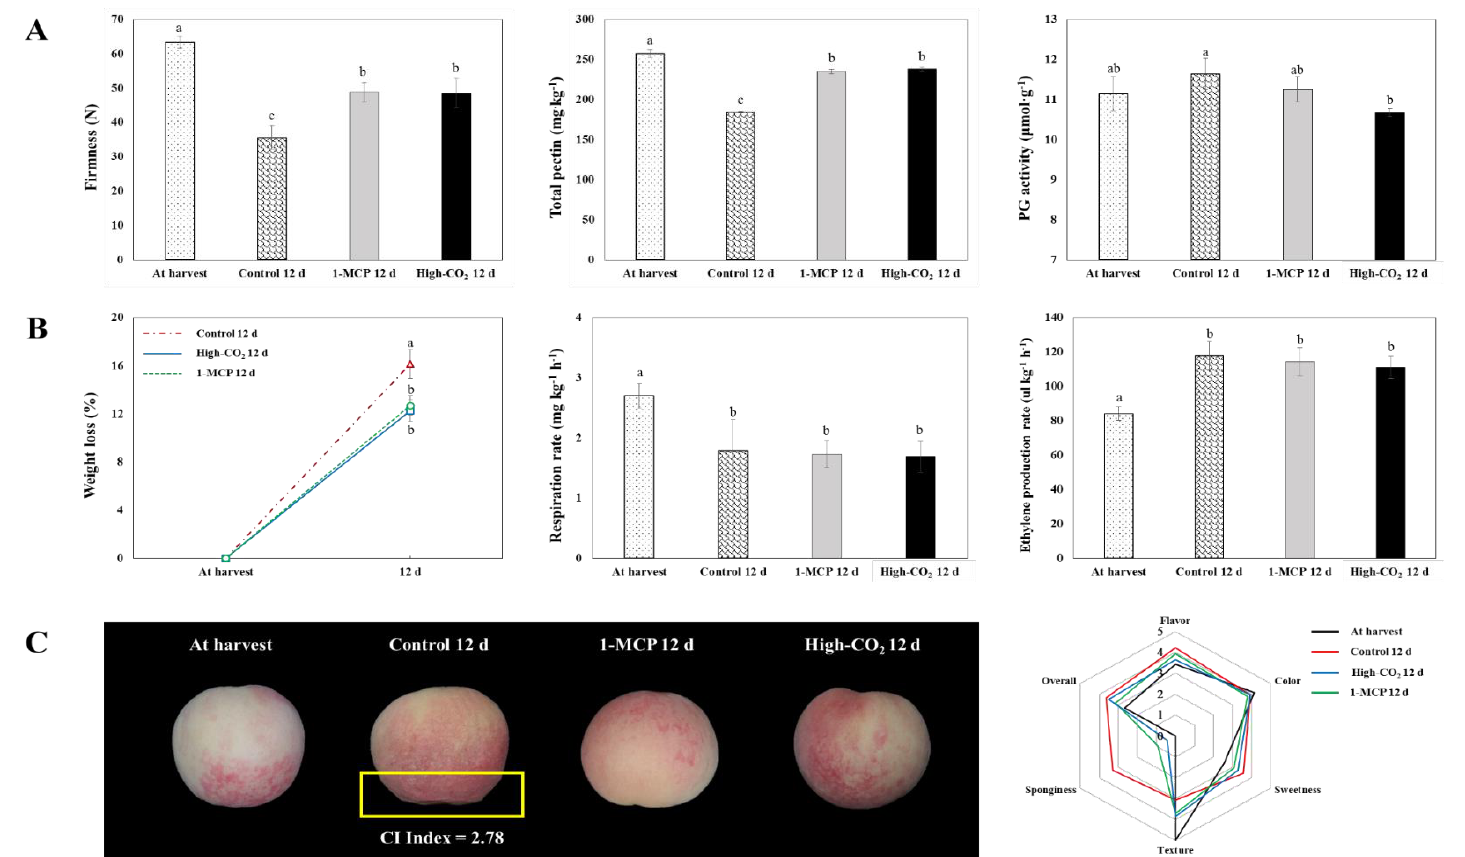
Figure 4. Firmness, total pectin, PG activity ( A ); weight loss, respiration rate, ethylene production rate ( B ); and fruit appearance, CI index, and sensory qualities ( C ) of ‘Madoka’ peach fruit at harvest and after 12 days storage at 0 °C with pre-storage 1-MCP and high CO 2 treatments or without treatment (control). Data for firmness, CI index, and sensory quality are presented as a mean of 10 biological replicates ± standard errors. Total pectin, PG activity, weight loss, respiration rate, and ethylene production rate are presented as a mean of three replicates ± standard errors. Different letters on the bars indicate significant difference between treatments with Duncan’s multiple range test at p ≤ 0.05.